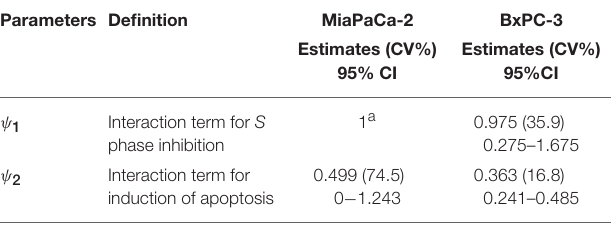
TABLE 4 | Pharmacodynamic interaction model parameter